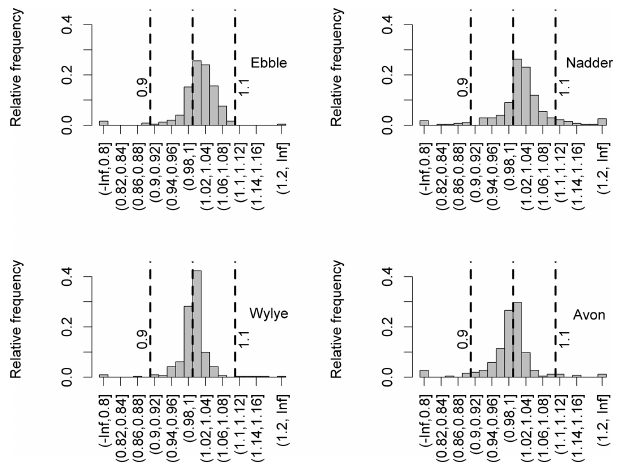
Figure 8. Distributions of the ratio of DO deficit at points of zero DO change to the regression